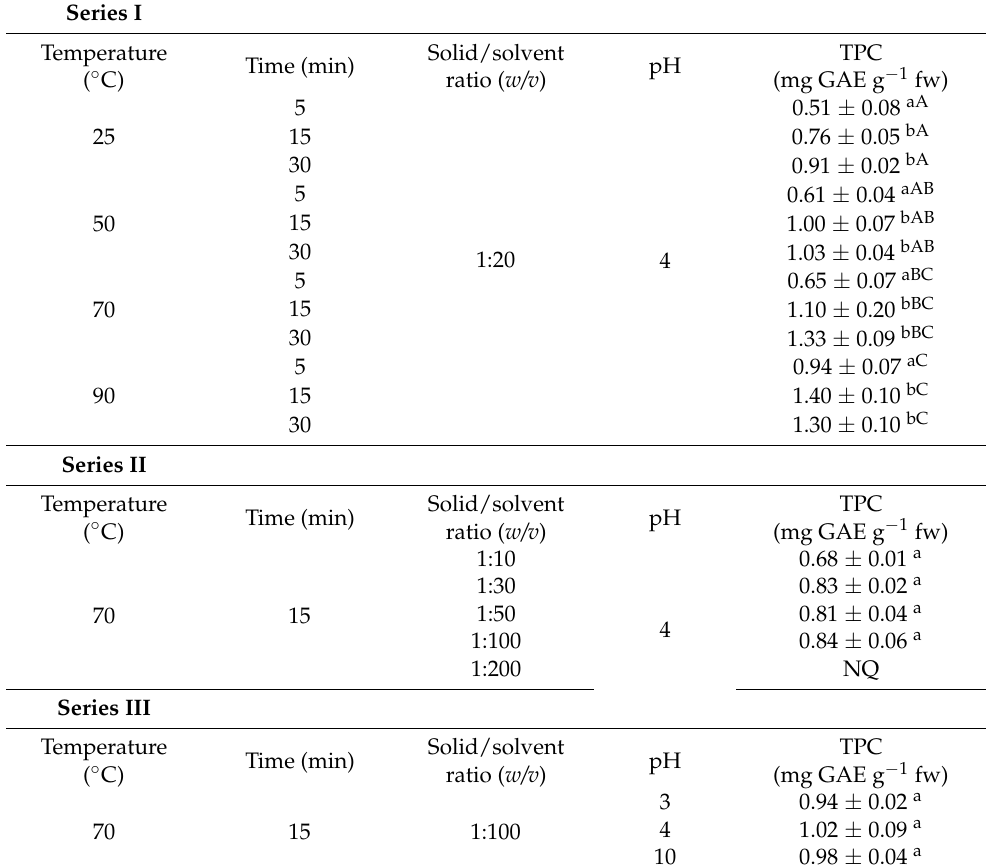
Table 1. Assessment of the influence of the experimental factors on the TPC recovery from orange